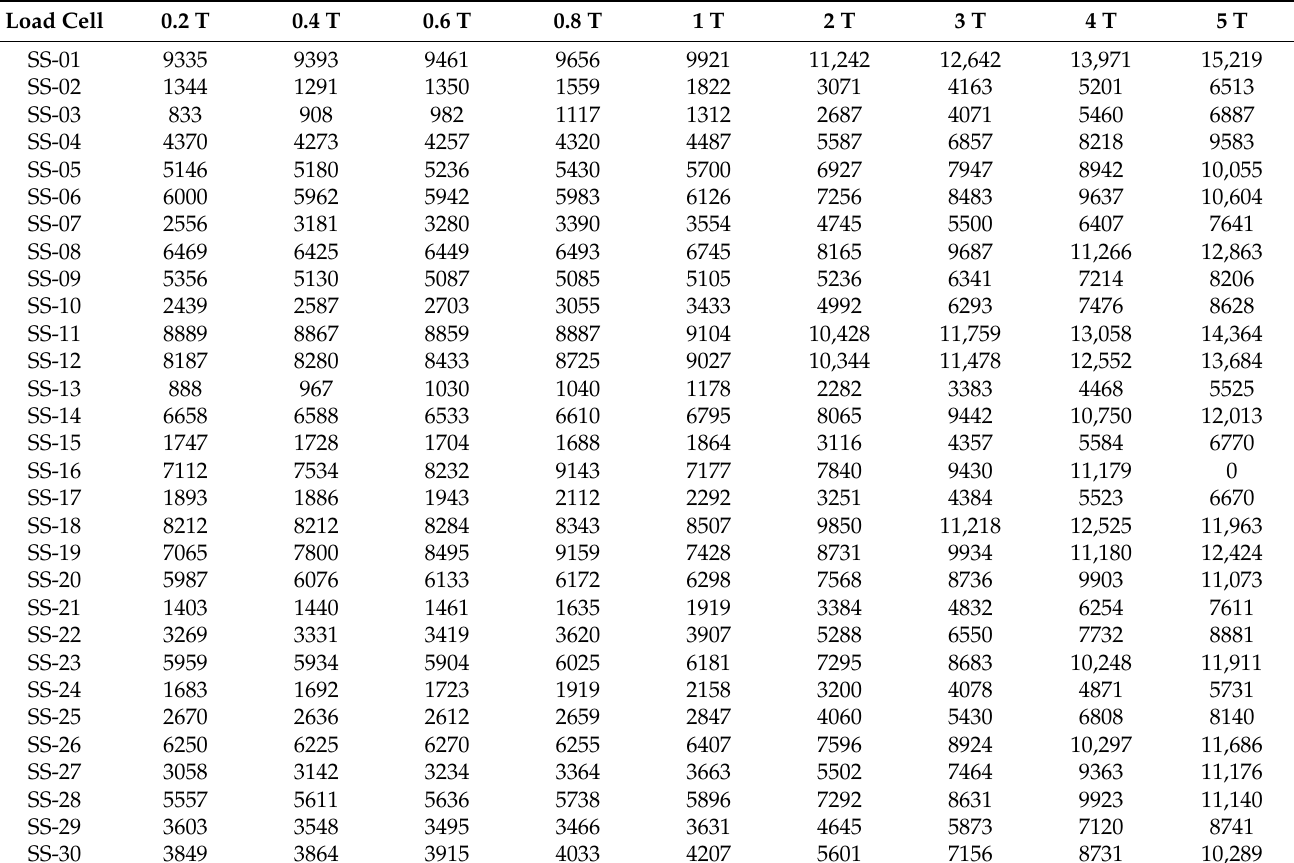
Table 3. Data from compressive load experiment using